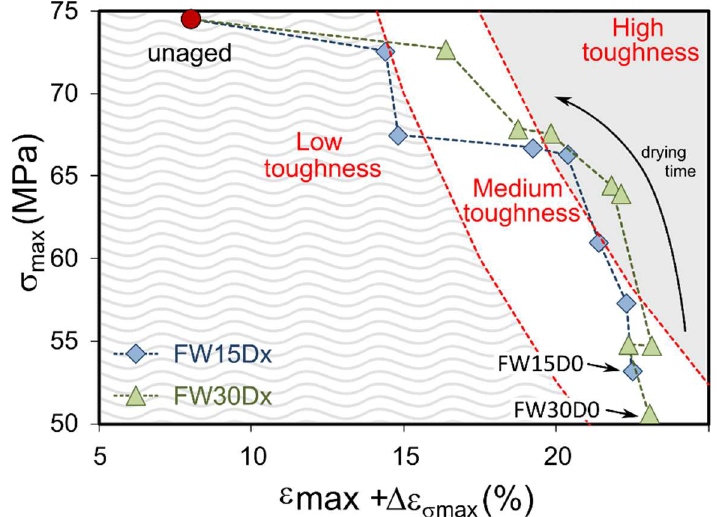
Figure 6. σ max vs. εmax + ε σmax plots for FW15 and FW30 samples.